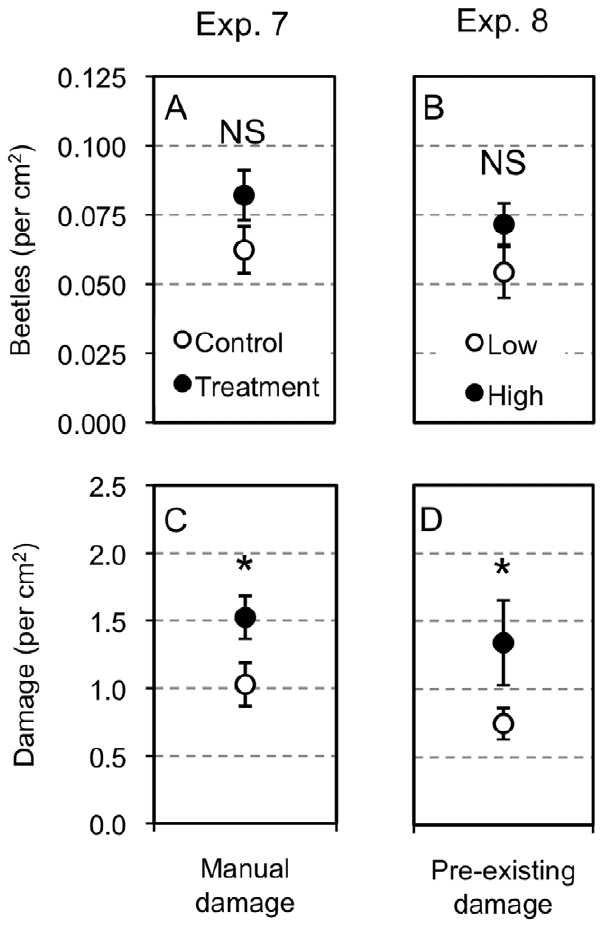
Figure 3. Effect of leaf damage on beetle choice and herbivory. Experiments 7–8 treatment means ( 6 SE) number of beetles per cm 2 (A,B) and damage per cm 2 (C,D). Exp. 7 compares manually damaged leaves versus un-damaged control leaves (A,C). Exp. 8 compares leaves with high- versus leaves with low-pre-existing damage (B,D). Statistical differences between ant and control treatment means are represented as: NS= P . 0.05, *= P , 0.05, **= P , 0.01, ***= P , 0.001.